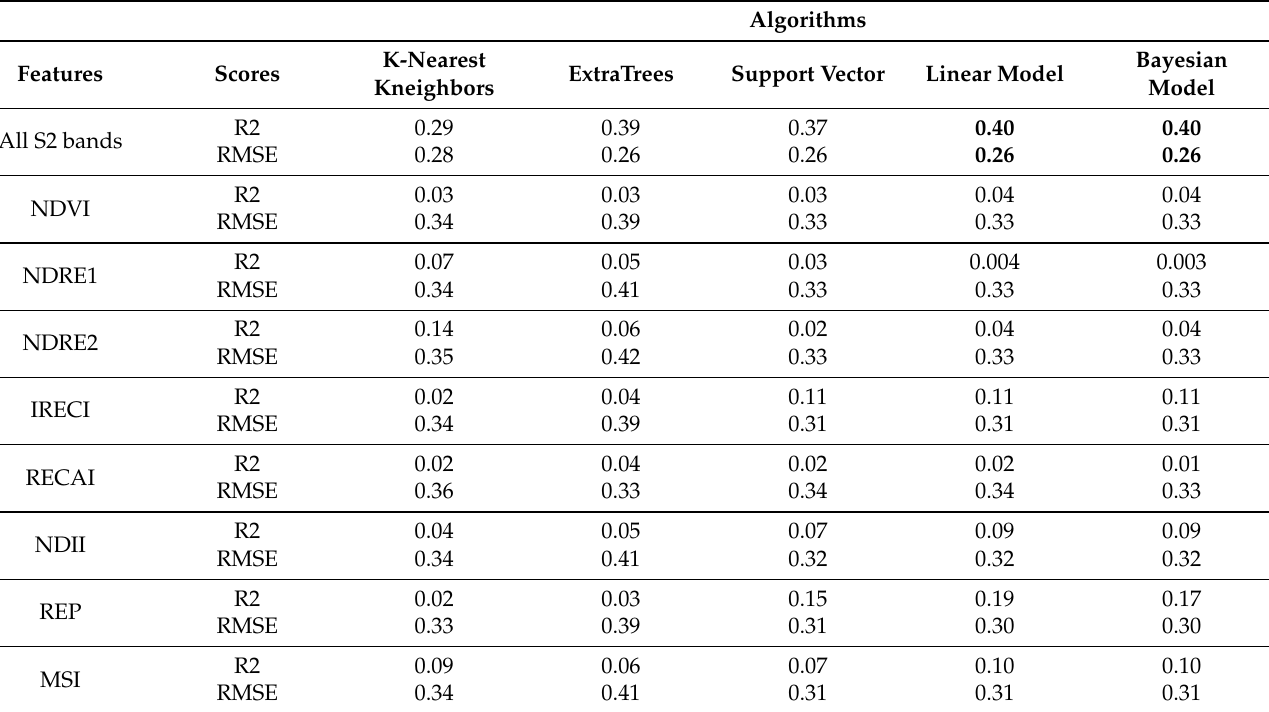
Table 8. Results of scores exploration for all data (all years, all inter-row management). Best scores are highlighted in bold.